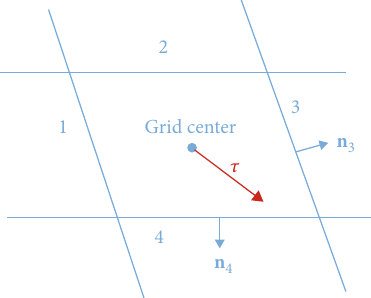
Figure 3: Schematic of fl ow directions in an individual control